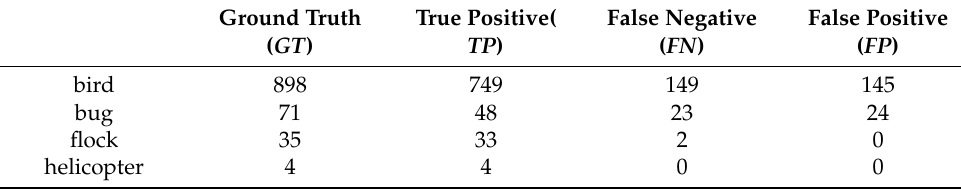
Table 3. The assignment of the various types of objects to the GT , TP , FP , and FN sets. Ground Truth ( GT